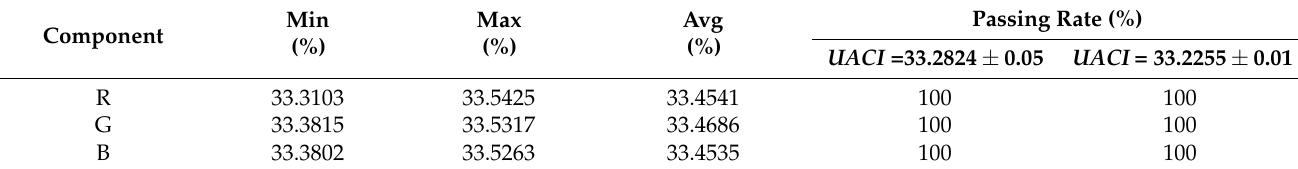
Table 7. Statistical results of UACI in Table 5.